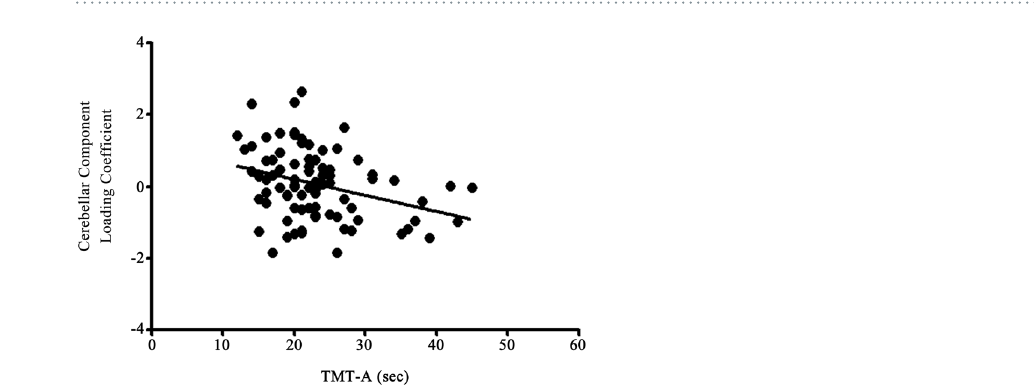
Figure 2. The association between structural networks and intelligence quotient (IQ). ( a ) Correlation between intelligence and the cerebello-parietal component; ( b ) correlation between intelligence and the frontal component.